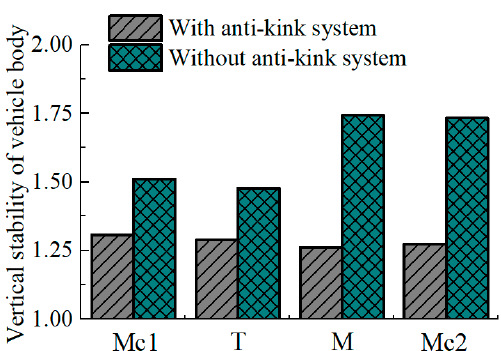
Figure 13. Lateral stability of vehicle body. Figure 14. Vertical stability of vehicle body. Figure 14. Vertical stability of vehicle Figure 14. Vertical stability of vehicle body.